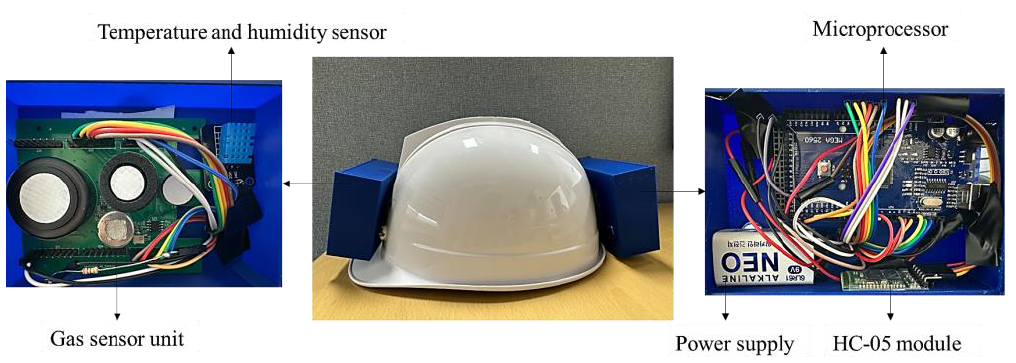
Figure 9. Developed helmet-mounted toxic gas monitoring and prevention system.